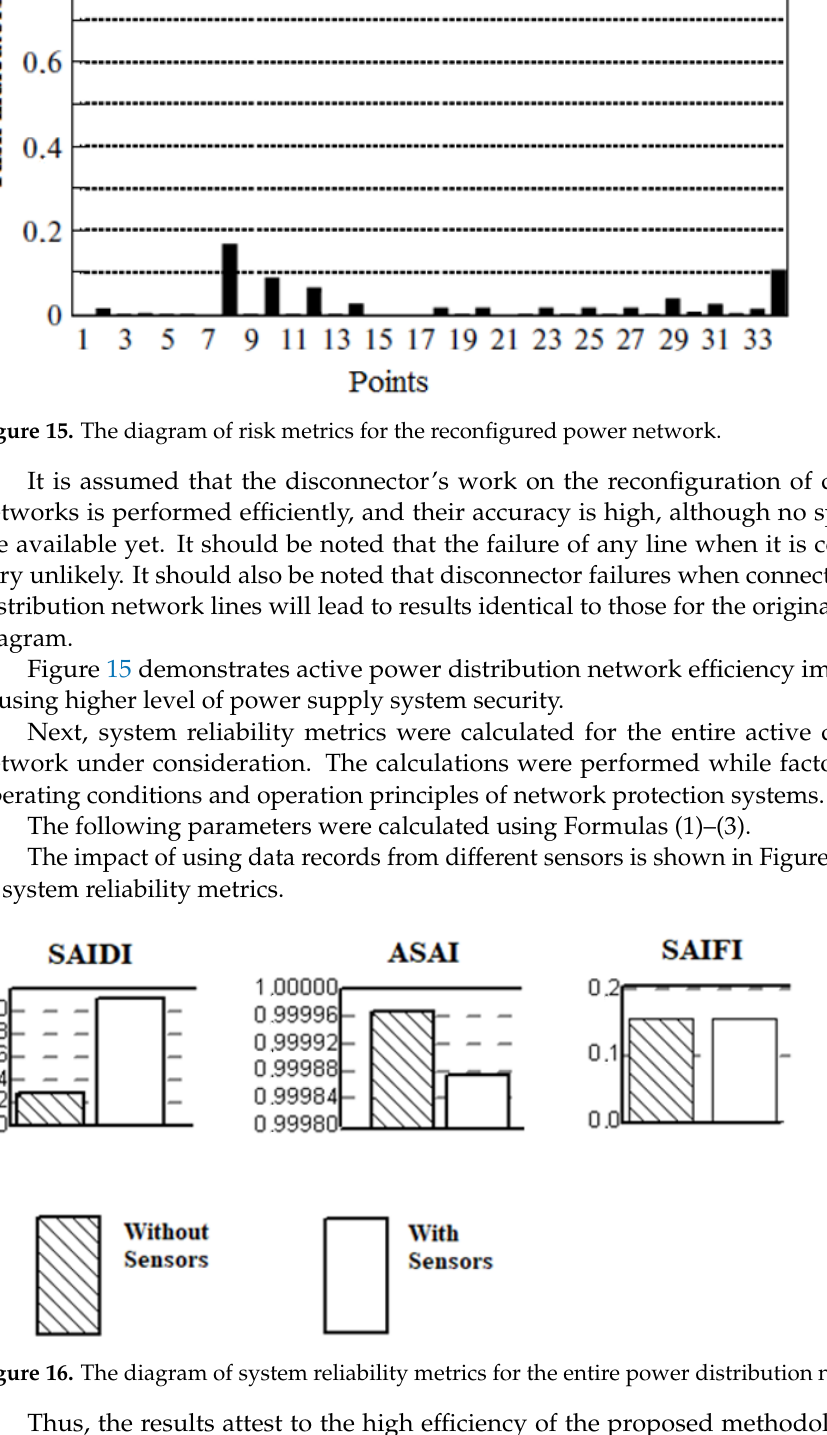
Figure 16. The diagram of system reliability metrics for the entire power distribution network.